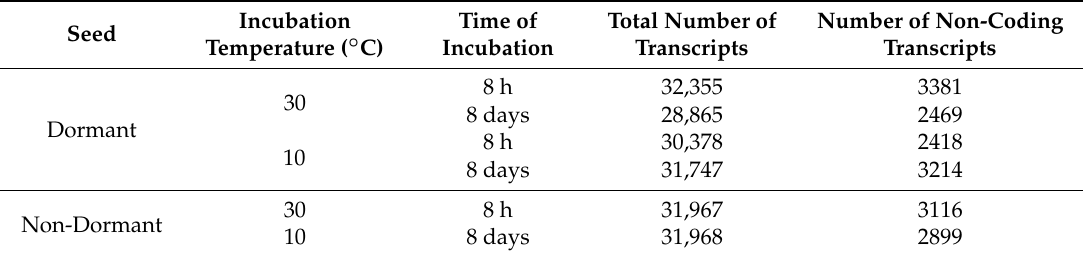
Table 2. Number of expressed sequences detected in imbibed